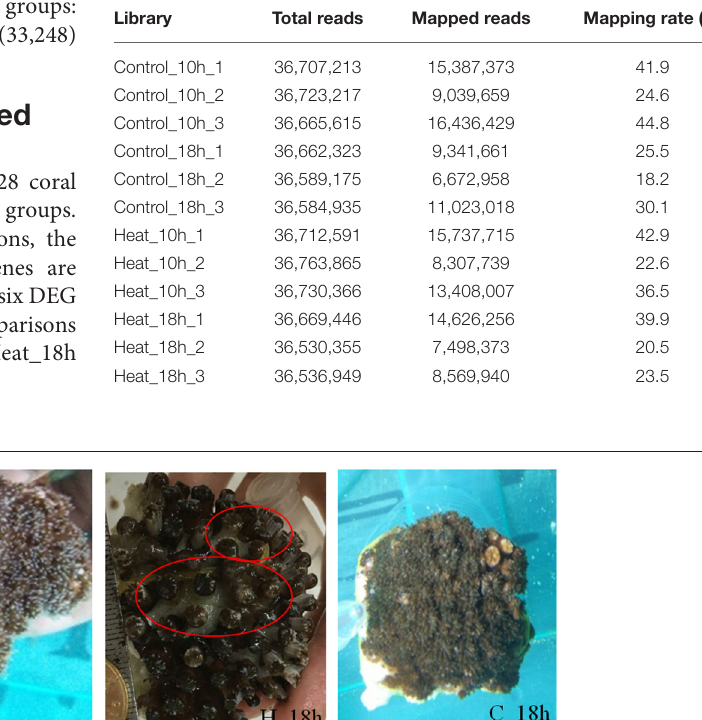
Frontiers in Genetics |